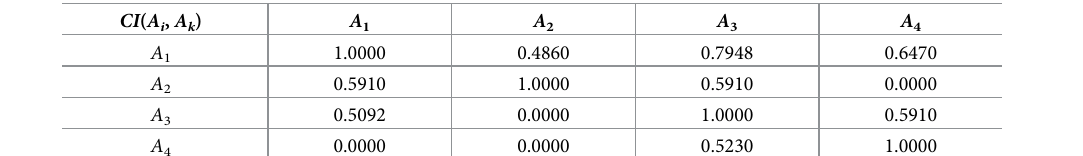
Table 8. Credibility degree CI ( A i , A k ).